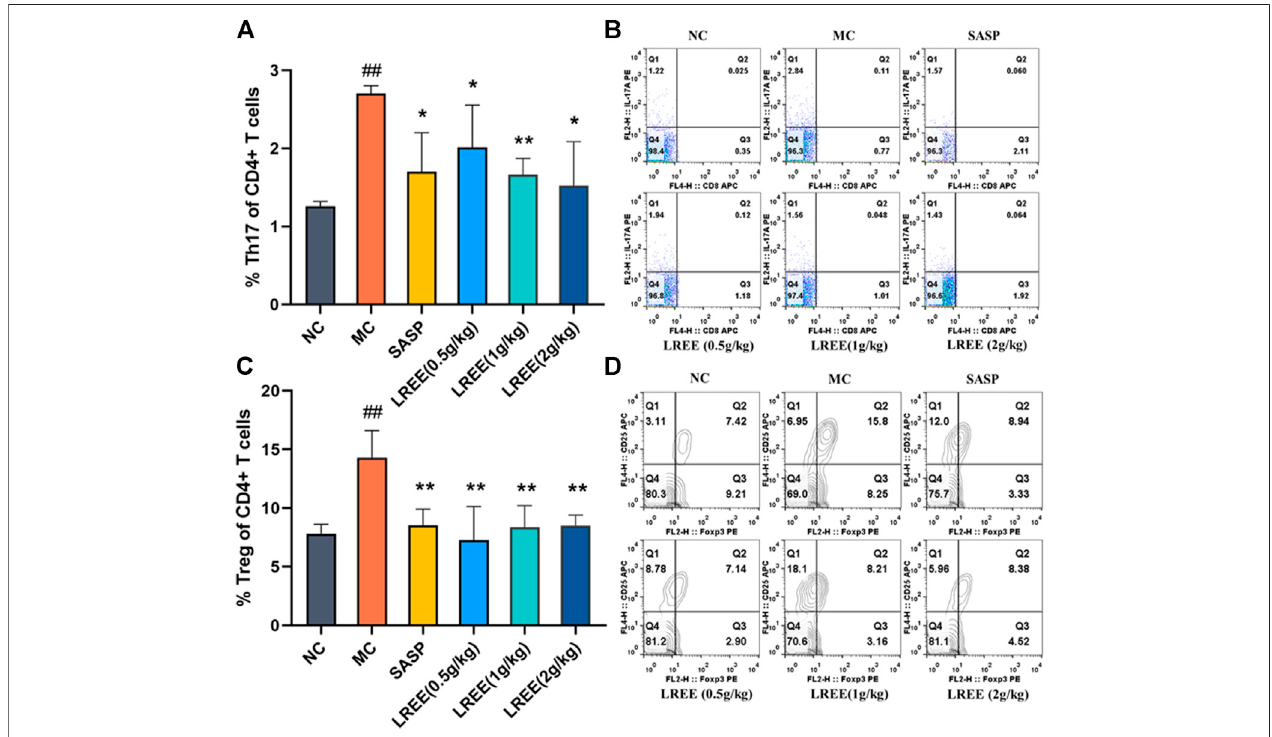
FIGURE 4 | Effects of LREE on the proportion of Th17 and Treg cells in the MLNs of ulcerative colitis model mice ( n (cid:2) 6). (A, C) Statistical analysis of of the proportion of Th17 and Treg cells in MLNs. (B, D) Detection of the proportion of Th17 and Treg cells in MLNs. # P ＜ 0.05, ## P ＜ 0.01 vs. NC group. * P ＜ 0.05, ** P ＜ 0.01 vs. MC group.